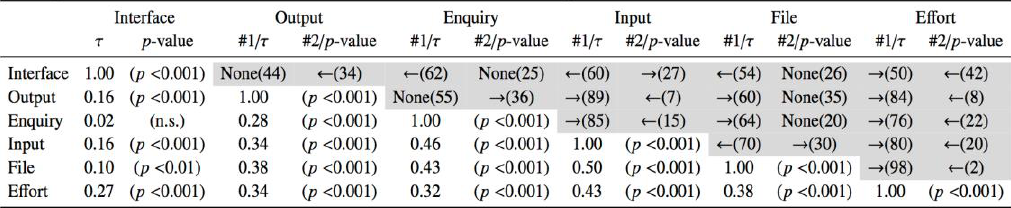
Table 5. Results of upper two causal-effect relationships (mixture: 5) and Kendall’s t and p -values for Finnish dataset. Upper triangular indicates causal-effect relationships. Lower triangular matrix